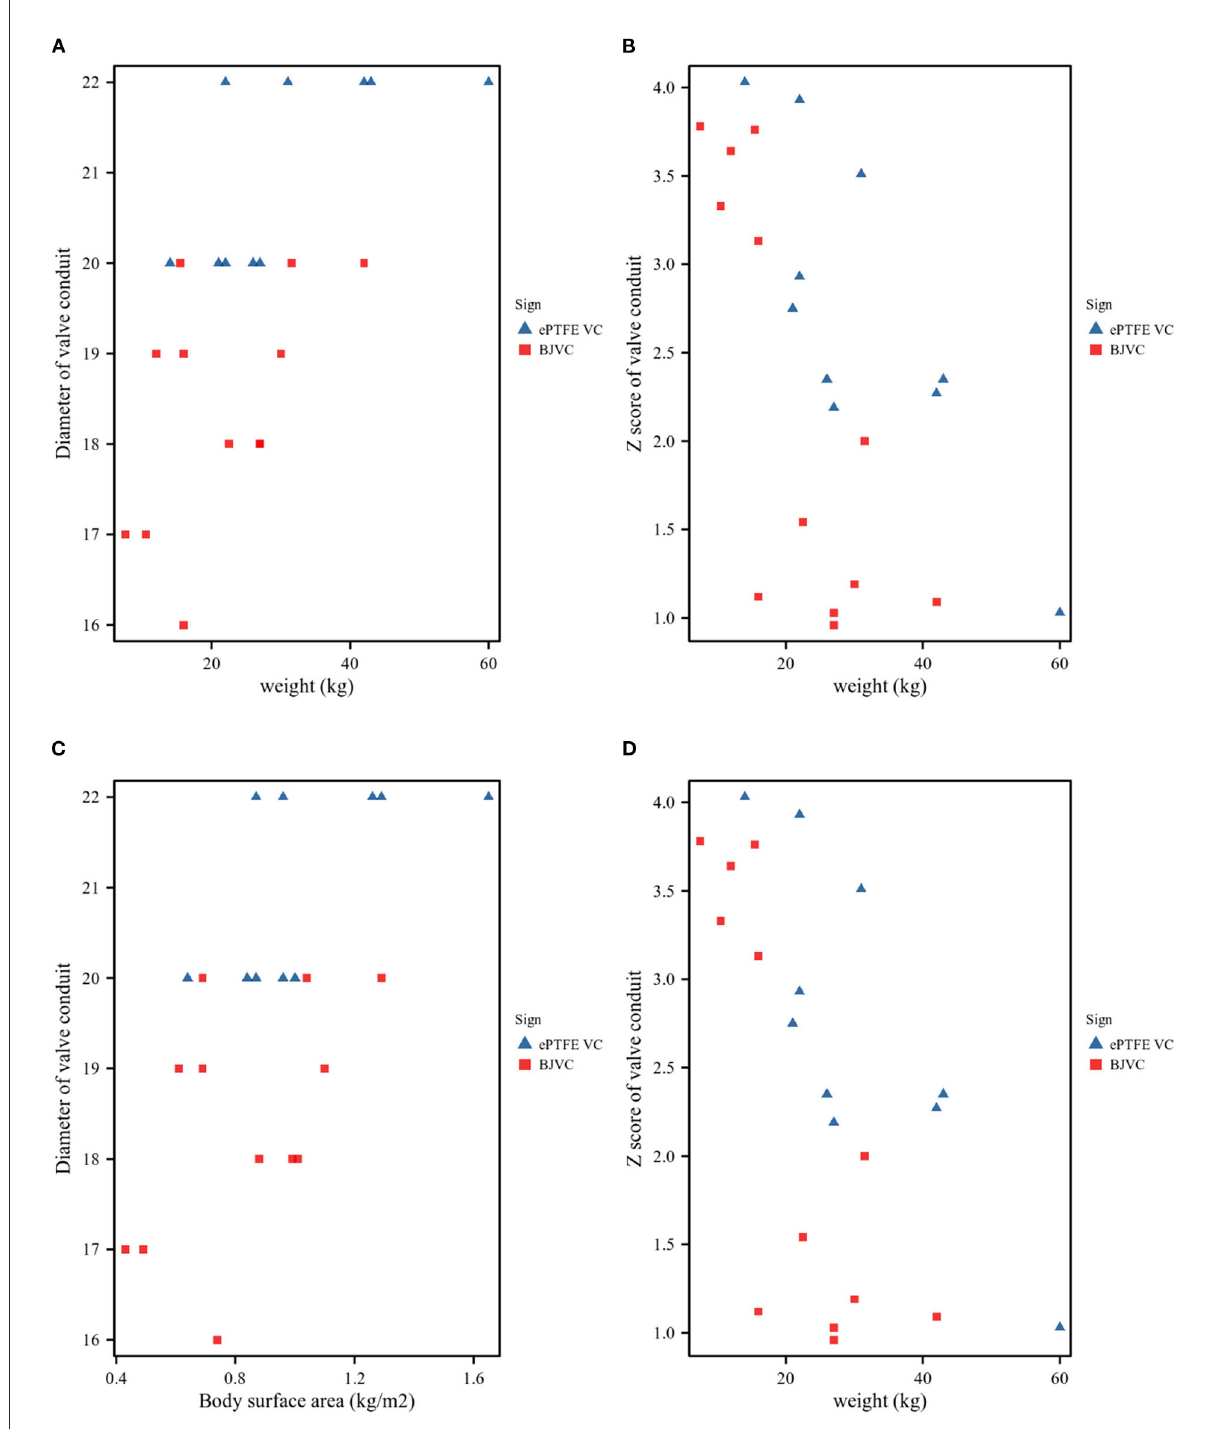
FIGURE1 Conduit size. (A) . Patient weight and conduit diameters. (B) . Patient weight and Z-values of the conduit. (C) . Patient body surface area (BSA) and conduit diameters. (D) . Patient BSA and Z-values of the